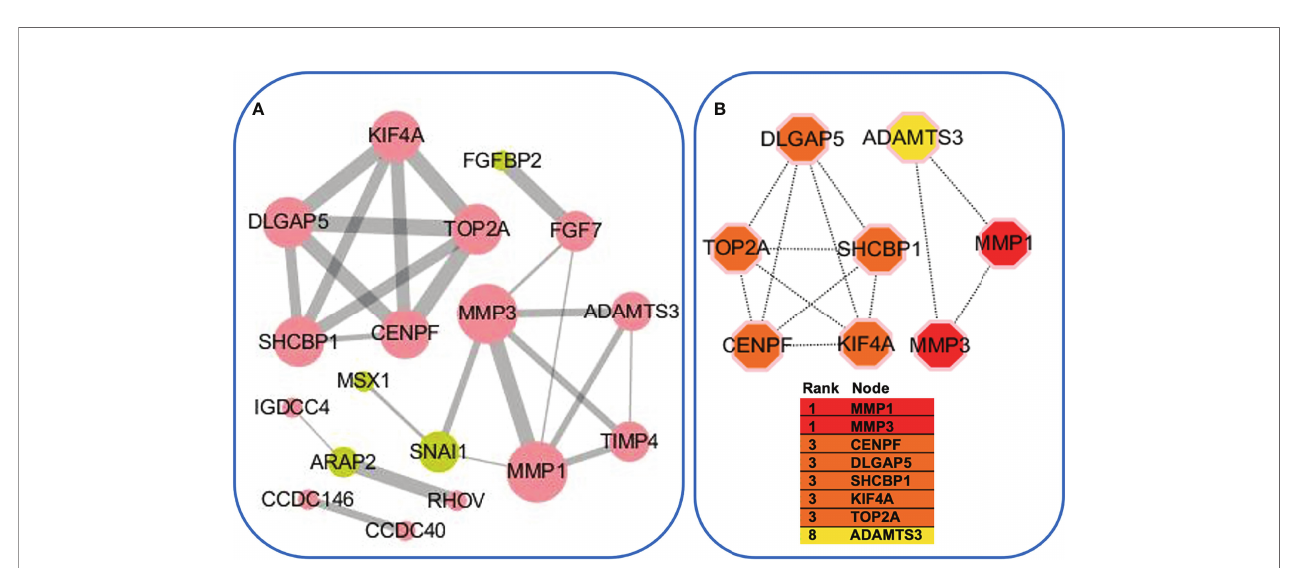
FIGURE 3 | Protein – protein interaction (PPI) network. (A) PPI enrichment analysis of differentially expressed genes (DEGs). The nodes denoted proteins, and the edges denoted interactions. The red and green circles represented the up- and down-regulated proteins encoded by DEGs, respectively. The node size and edge width re fl ected the degree of connectivity. (B) Subnetwork of eight hub genes from the PPI network. Node color re fl ected the degree of connectivity (red to yellow color represent a higher degree to a lower degree).